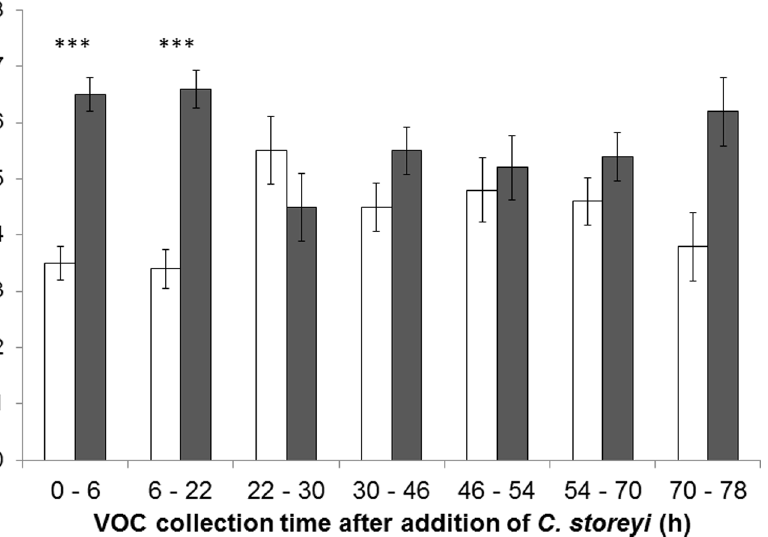
Figure 1. Behavioural response (mean number ± SE) of Cicadulinastoreyi adult leafhoppers to VOCs collected from cis -jasmone (CJ)- treated, adult C.storeyi -infested maize ( Zeamays ) seedlings versus VOCs collected from control-treated, adult C.storeyi -infested maize seedlings in a Y-tube olfactometer. VOCs were collected 0–3 h, 3–6 h, 6–22 h, 22–30 h, 30–46 h, 46–54 h, 54–70 h and 70–78 h after addition of C. storeyi . n=10. Data were analysed using a paired t -test. *** P , 0.001. White columns=control treatment, then C. storeyi infestation. Grey columns=CJ treatment, then C. storeyi infestation. doi:10.1371/journal.pone.0062299.g001 PLOS ONE |